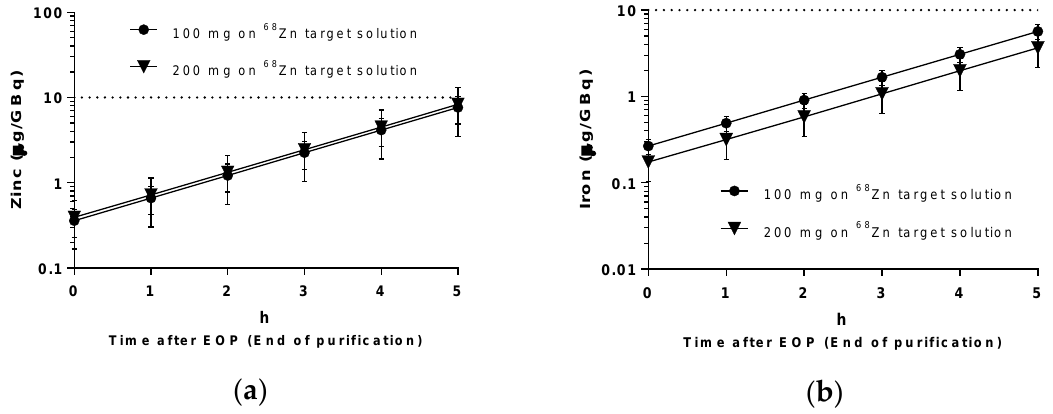
Figure 5. Chemical purity of final 68 Ga-peptide formulation. The product complies with the Ph. Eur. regarding the maximum amount in µg of Zinc ( a ) and Iron ( b ) per GBq of activity. Values are decay corrected.